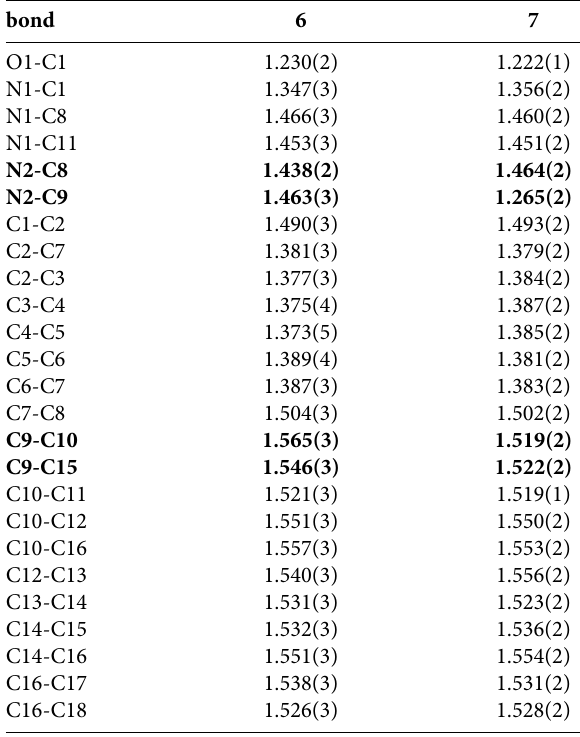
Table 2. Bond lengths in 6 and 7 (Å).